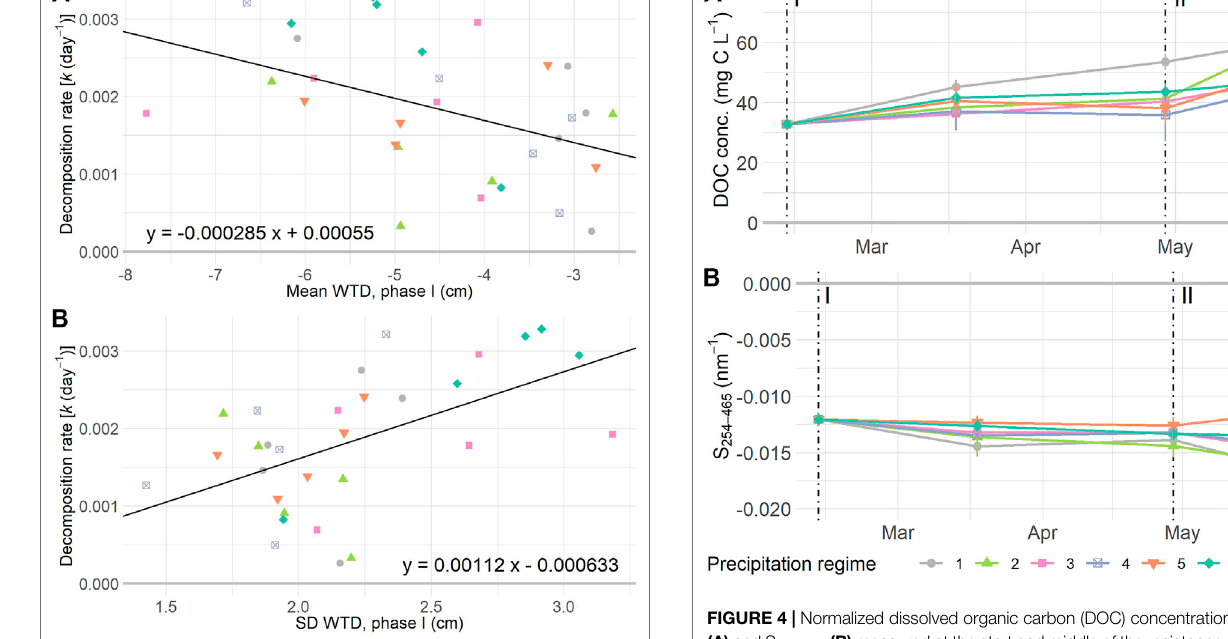
Frontiers in Environmental Science |